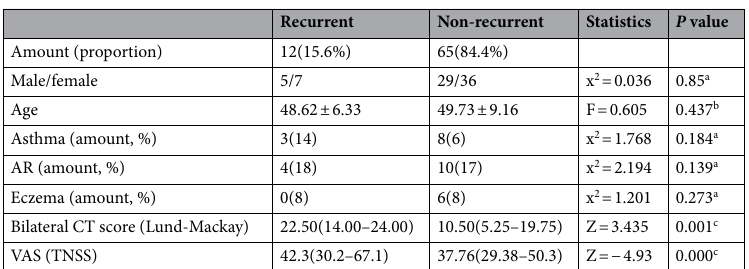
Table 1. Comparison of clinical characteristics of CRSwNP patients in the recurrent and non-recurrent groups. a Chi-square test, b single factor analysis of variance, c Mann-Whitney U test, P <